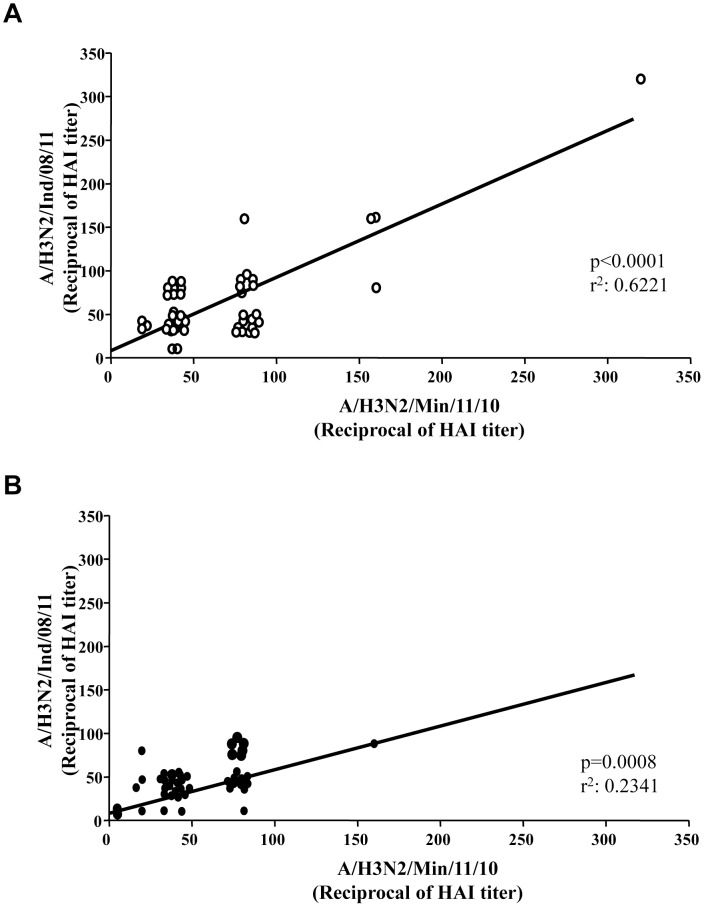
Correlation between humoral immune response to H3N2v strains.(A): The correlation between HAI titers to A/H3N2/Min/11/10 and to A/H3N2/Ind/08/11 is shown in HD. Pearson's r2 and significance, as well as the calculated regression line. (B): The correlation between HAI titers to A/H3N2/Min/11/10 and to A/H3N2/Ind/08/11 is shown in HIV+. Pearson's r2 and significance, as well as the calculated regression line.